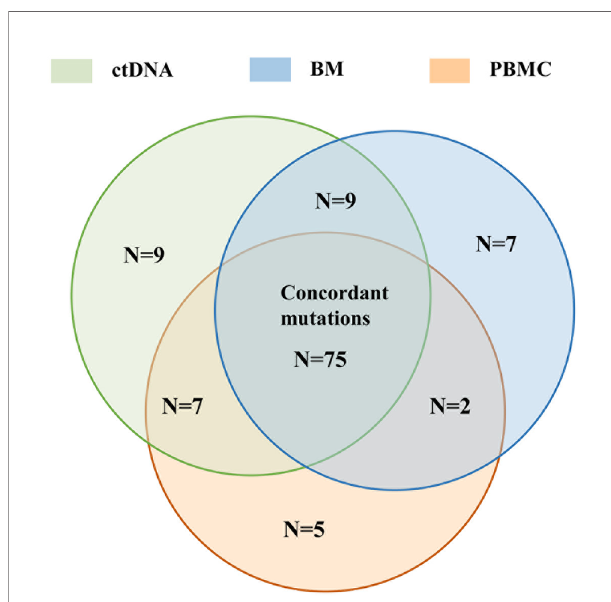
FIGURE 8 | The concordance of the number of mutation detected in BM, ctDNA, and PBMC with clinical signi fi cance detected by all